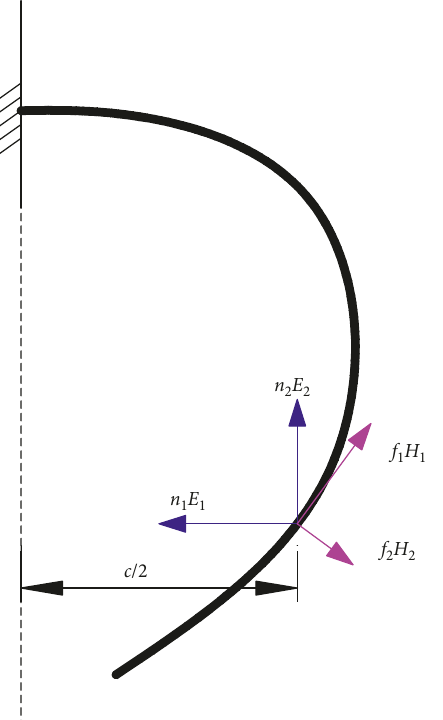
Figure 9: At point s � ξ , the object is in contact with the soft robot. The object is assumed to remain stationary due to the static friction force ⇀ H f and the normal force f 1 1